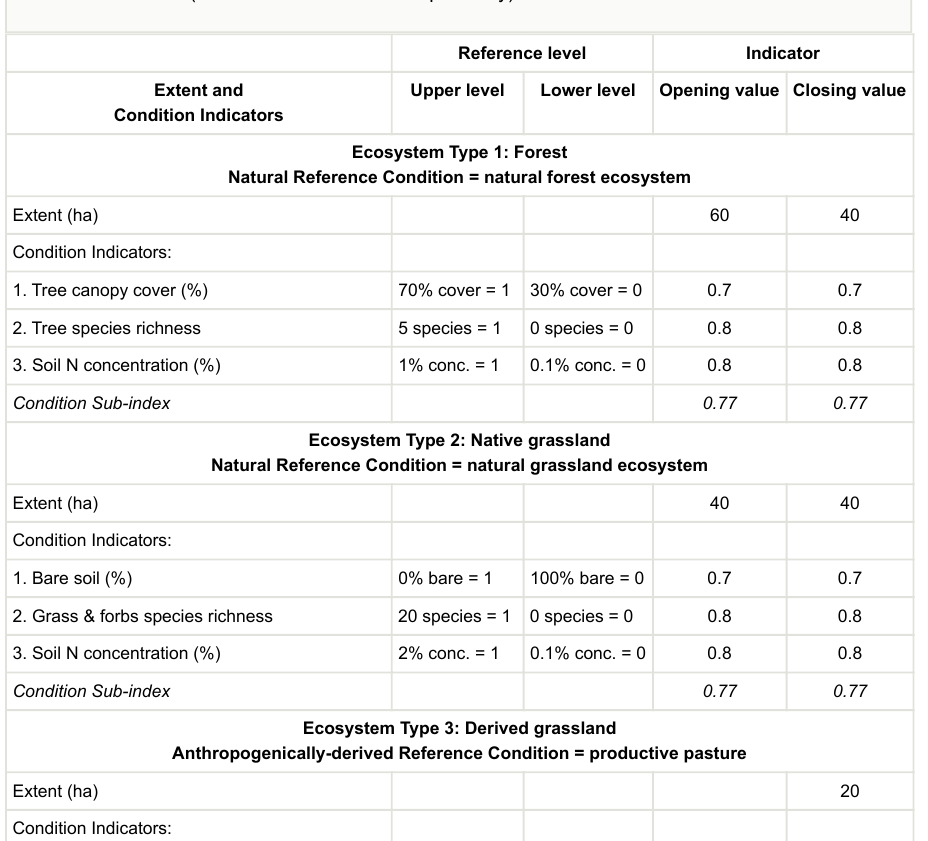
Ecosystem conversion from a forest to a grassland showing a change in ecosystem extent and condition accounts (numbers in cells are examples